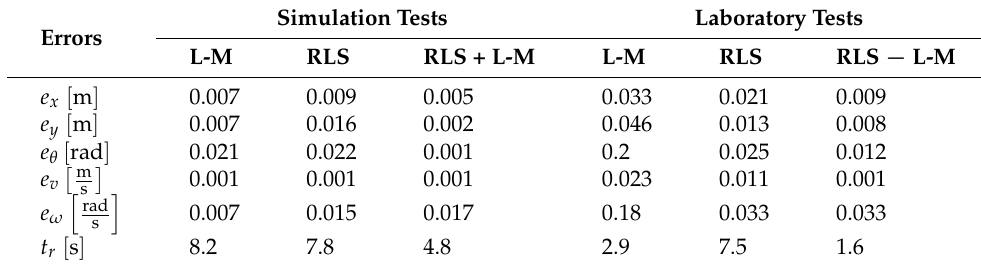
Table 4. A summary of the errors determined in the studies